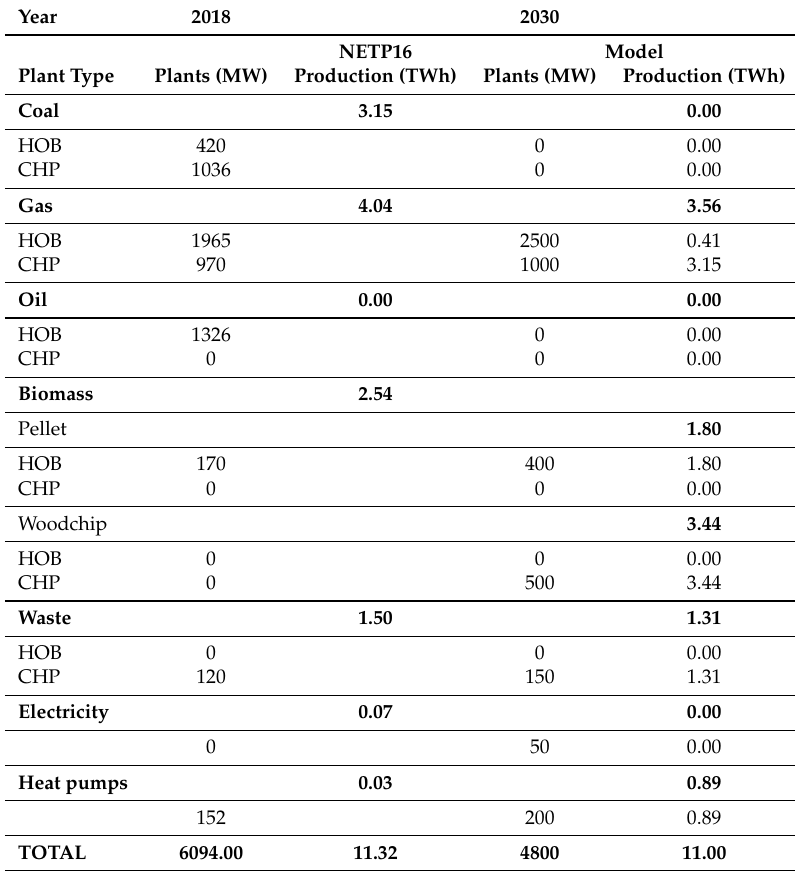
Table 4. The realized district heating (DH) production mix in the Helsinki Metropolitan area in 2018 and the approximate mixes and production amounts for 2030